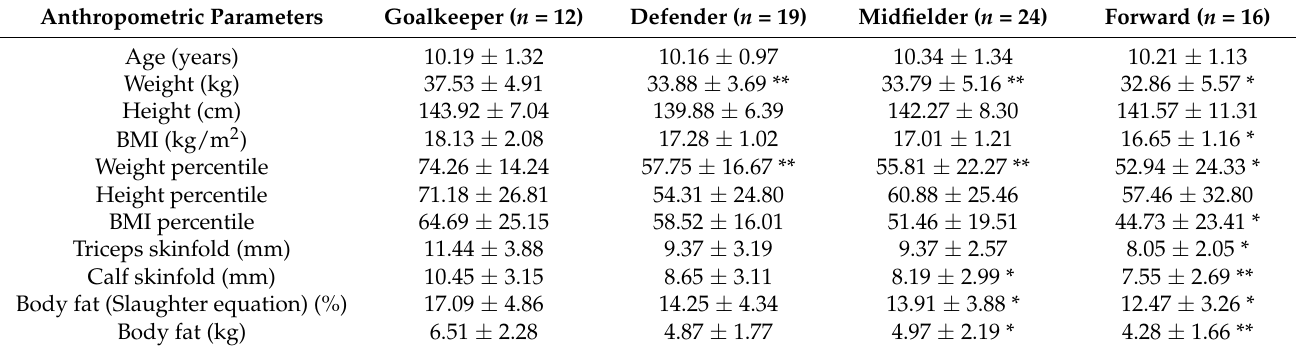
Table 3. Anthropometric parameters by field position for total